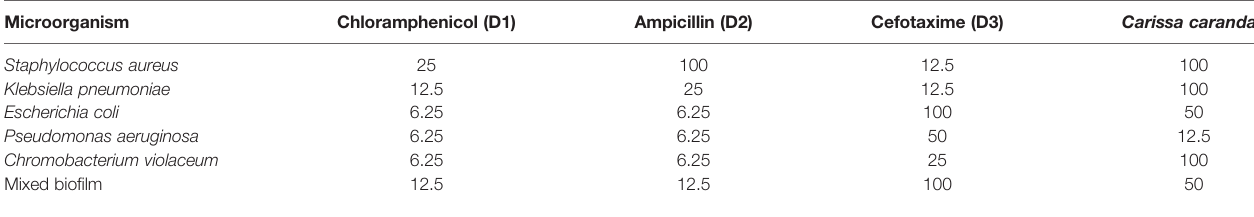
TABLE 2 | Minimum inhibitory concentration of the selected plant protein (in m g/ml).